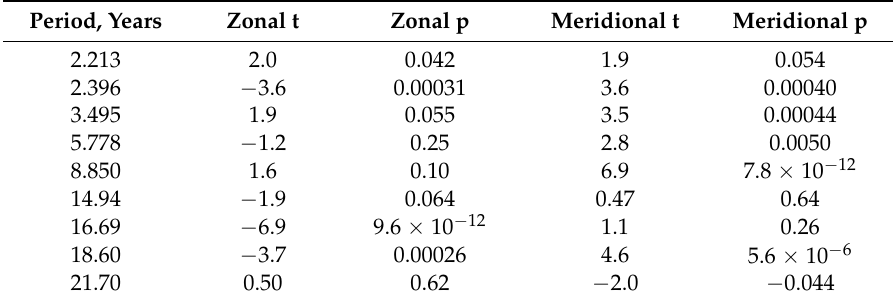
Table 12. Regime differences in multiple linear regression t and p statistics of subdecadal tidal components against monthly AMO data with lag 0.04 years and after removing the ~60-year oscillation with the F(t) function. Samples: N(zonal) = 954; N(meridional) = 978.